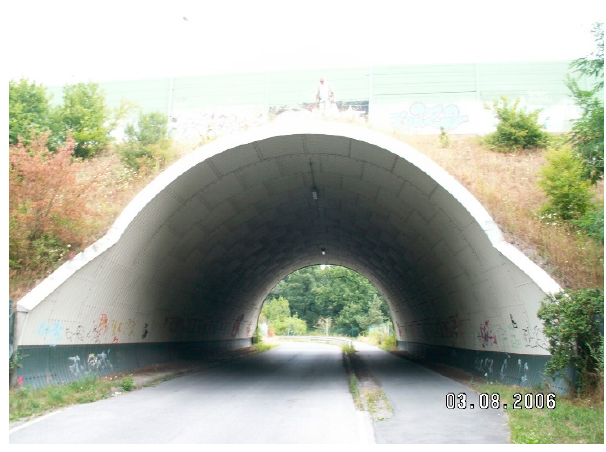
Figure 1. Side view of a soil–steel bridge in Germany.